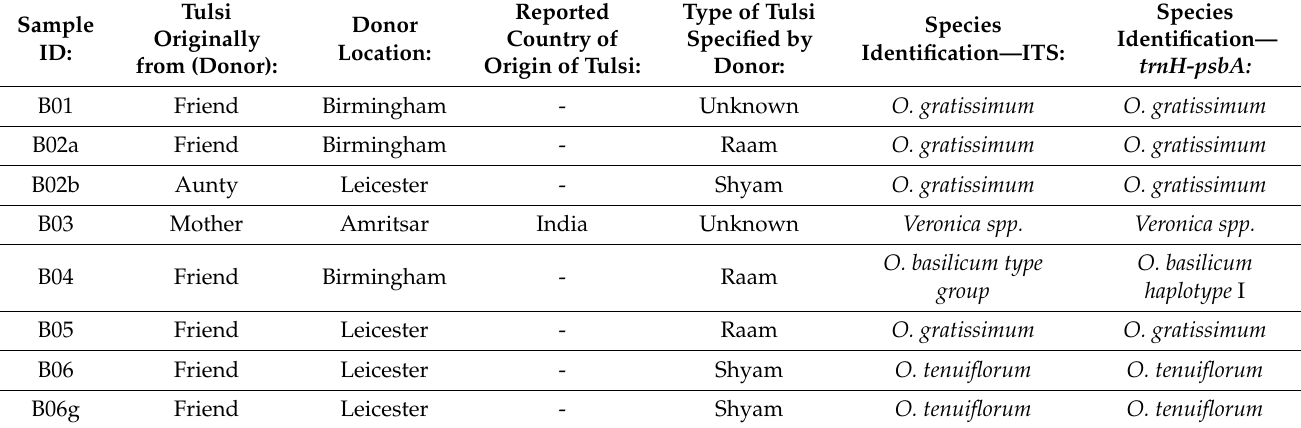
Table 2. Community Tulsi samples species identification